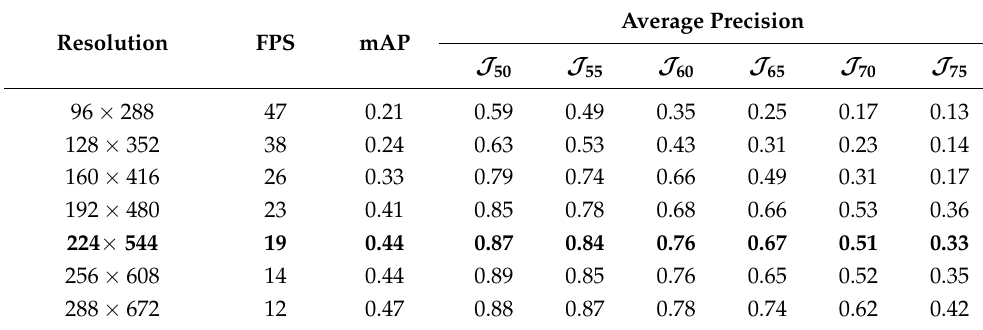
Table 2. Speed-accuracy trade-off for tree stem detection. The row in bold indicates the training resolution. Resolution FPS